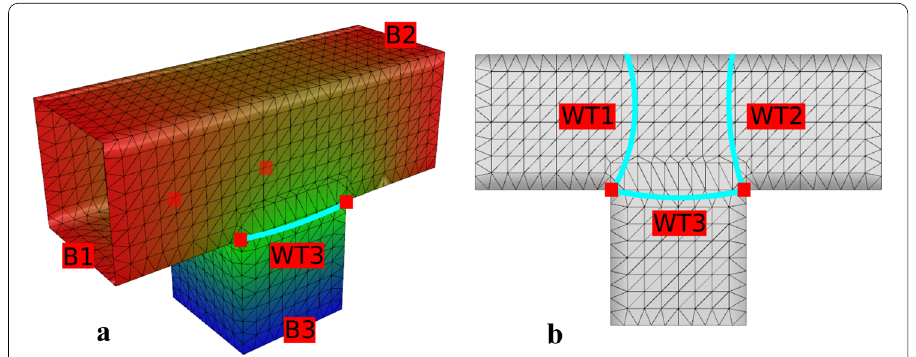
Fig. 6 Temporary cutting curves generation. a Discrete harmonic function f 3 . Blue color represents parametric values close to 0, red ones are close to 1. Using a set C of n c feature cutting points, f 2 and f 1 , the three temporary cutting curves are computed in ( b )